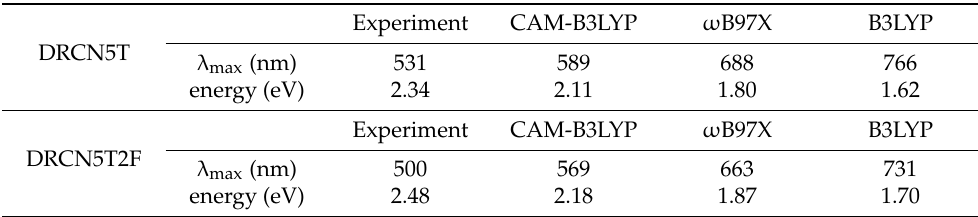
Table 1. The experimental and calculated absorption peaks in the visible region and corresponding energy of DRCN5T and DRCN5T2F.